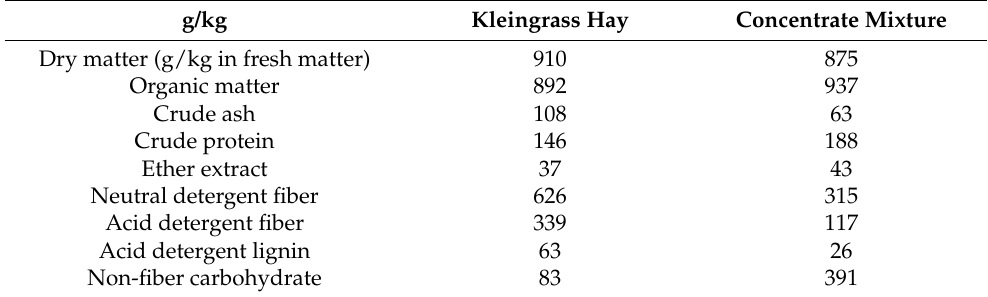
Table 1. Chemical composition of the basal diet (g/kg in dry matter) used for 24 h in vitro incubation.